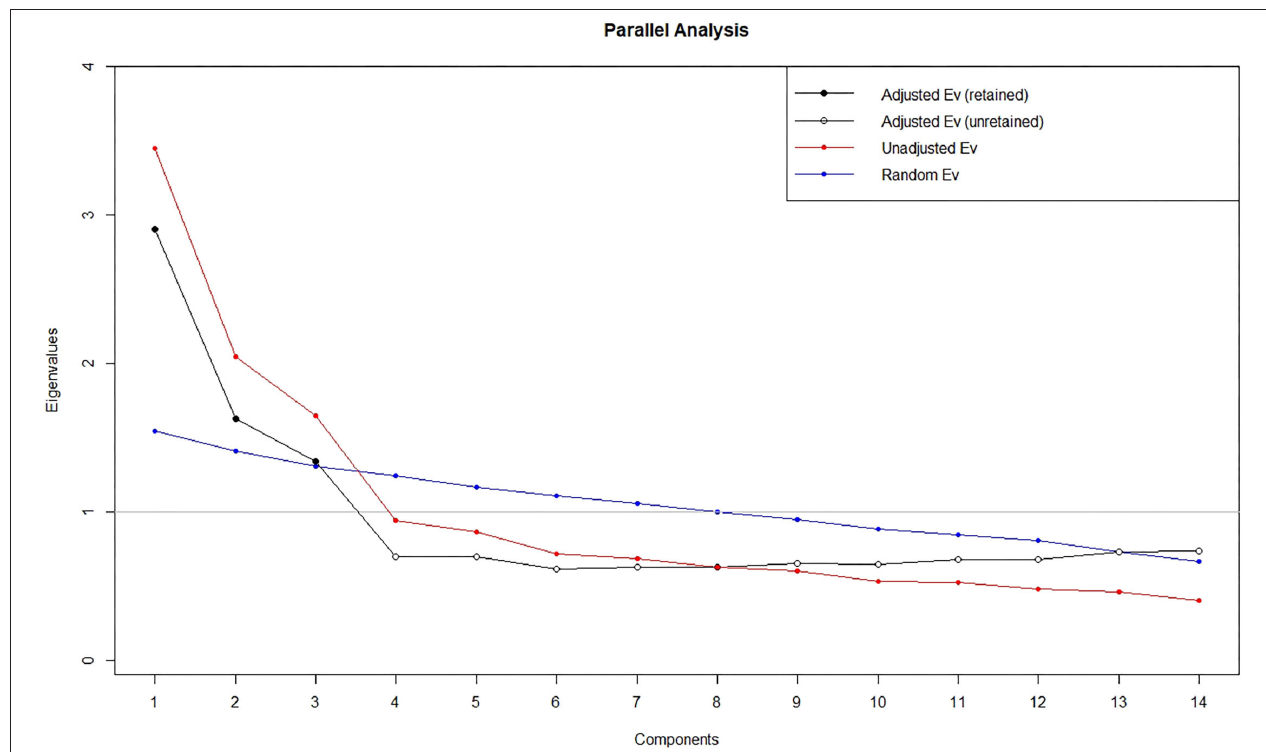
FIGURE 2 | Parallel analysis scree plot.